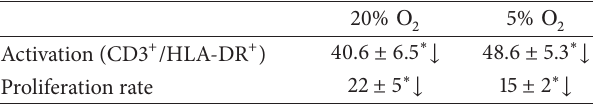
Table 1: Activation and proliferation rate of PBMCs after coculture with